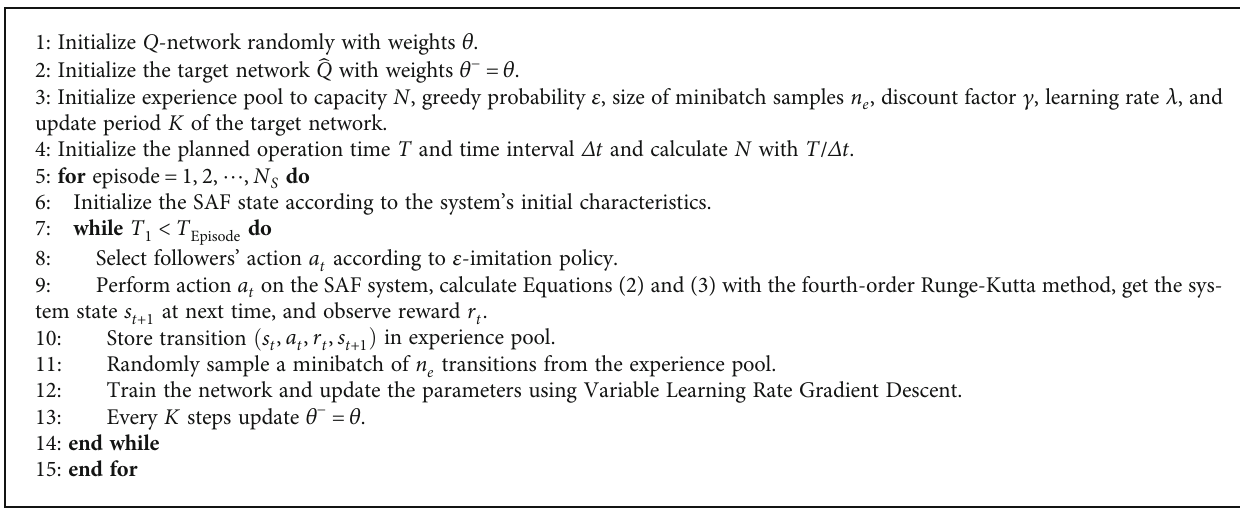
Algorithm 2: DQN